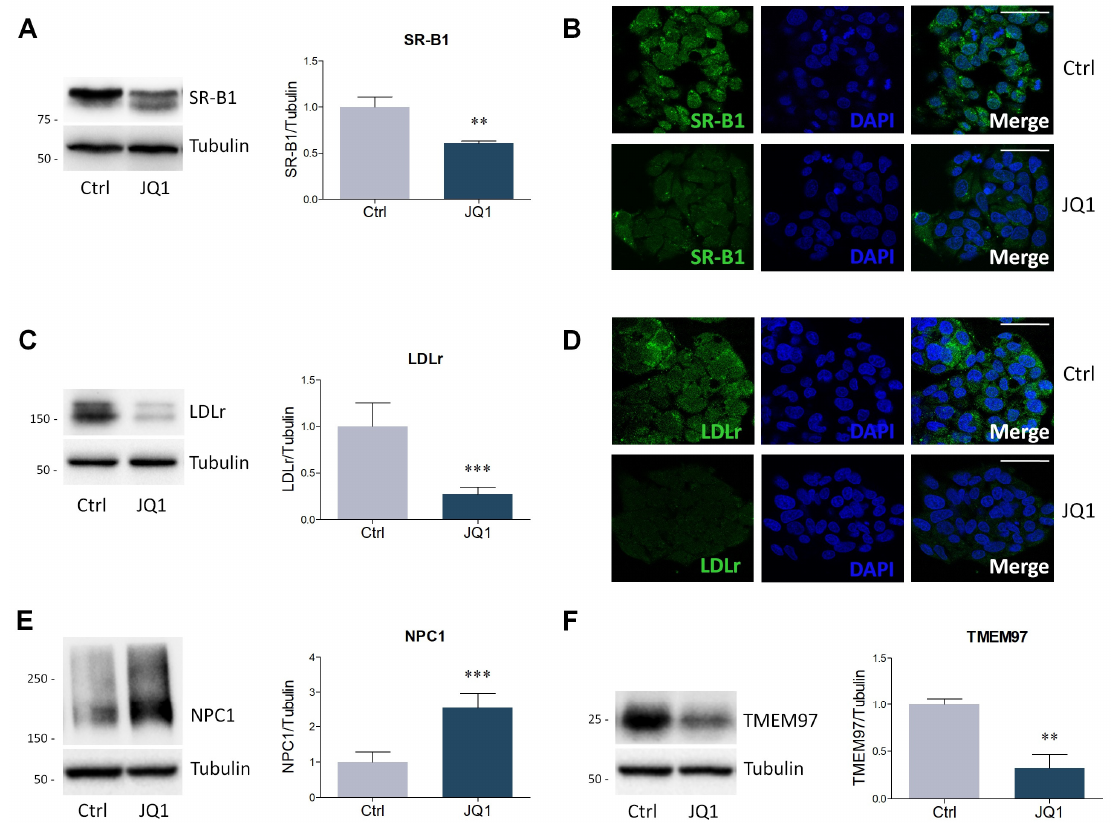
Figure 3. Expression of proteins involved in extracellular lipid uptake and intracellular cholesterol trafficking following JQ1 (0.4 µM) administration to HepG2 cells for 48 hours. ( A ) Representative Western blot (left panel) and densitometric analysis (right panel) of SR-B1. n = 6 independent experiments. ( B ) Immunofluorescence analysis of SR-B1 (green). Nuclei were counterstained with DAPI. n = 3 different experiments. Scale bar: 50 µm. ( C ) Representative Western blot (left panel) and densitometric analysis (right panel) of LDLr. n = 5 independent experiments. ( D ) LDLr immunofluorescence (green). Nuclei were counterstained with DAPI. n = 3 different experiments. ( E–F ) Representative Western blots and densitometric analysis of NPC1 and TMEM97. Tubulin was chosen as loading control. n = 6 independent experiments. Data represent means ± SD. Statistical analysis was performed by using unpaired Student’s t test. ** p < 0.01; *** p < 0.001.